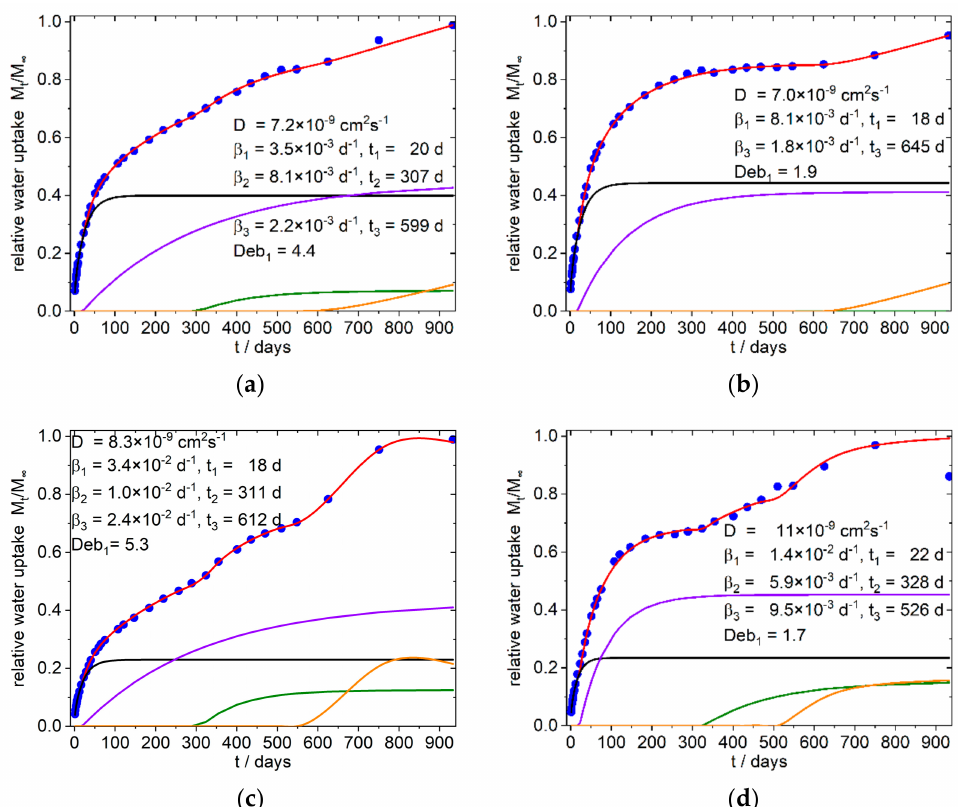
Figure 8. Simulation of water uptake of the 4:3-f/c-X Composites; ( a ) 4:3-f-8; ( b ) 4:3-f-16; ( c ) 4:3-c-8; ( d ) 4:3-c-16; the nearly identical shaped graphs for the corresponding 3:4-f/c-X composites are shown in the supplementary materials (Figure S8e,f,g,h); Blue dots: experimental normalized values, red line: simulation, black line: diffusion part of water uptake, purple and olive line: part of water uptake from the relaxation processes 1 and 2, orange line: part of water uptake from the exponential growth of water uptake or from the relaxation processes (see